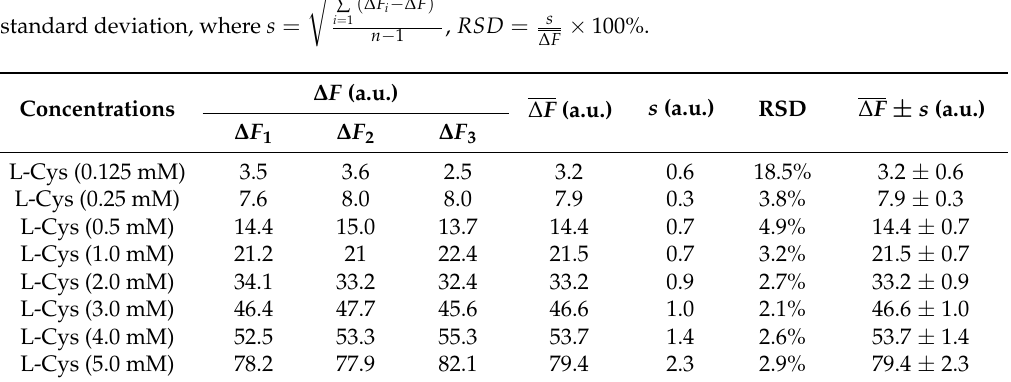
Table 1. PL data of the SiNPs-AuNPs FRET biosensor to different concentrations of L-Cys in Figure 6. The ∆ F 1 , ∆ F 2 and ∆ F 3 are fluorescence signal quenchings corresponding to three samples; ∆ F is the average value of the fluorescence signal quenching, s is the standard deviation and RSD is relative standard deviation, where s = Concentrations L-Cys (0.125